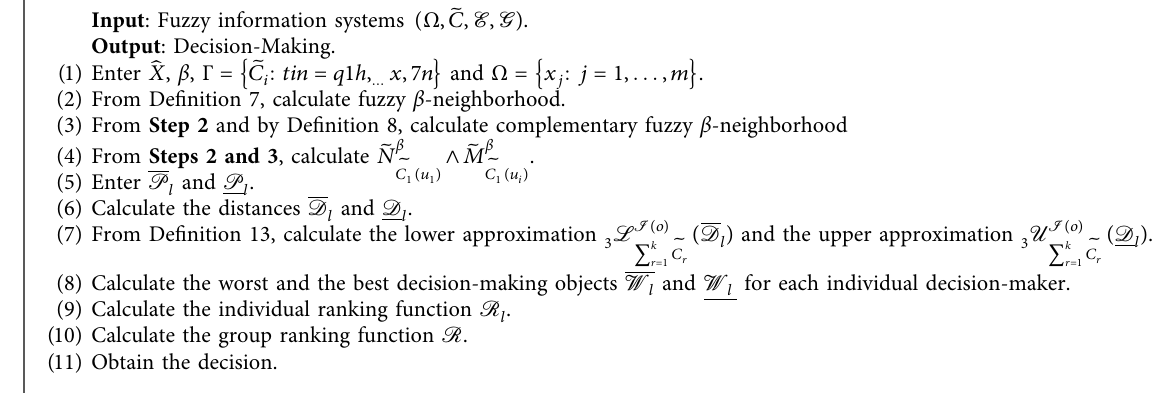
A LGORITHM 1: Algorithm for MAGDM with the TOPSIS